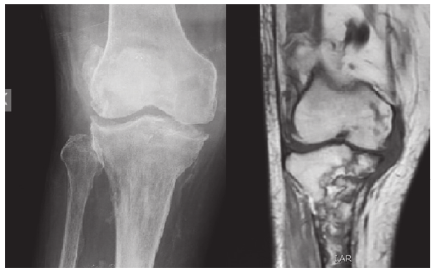
Figure 2: X-ray and MRI showing both knee septic arthritis and tibial and femur